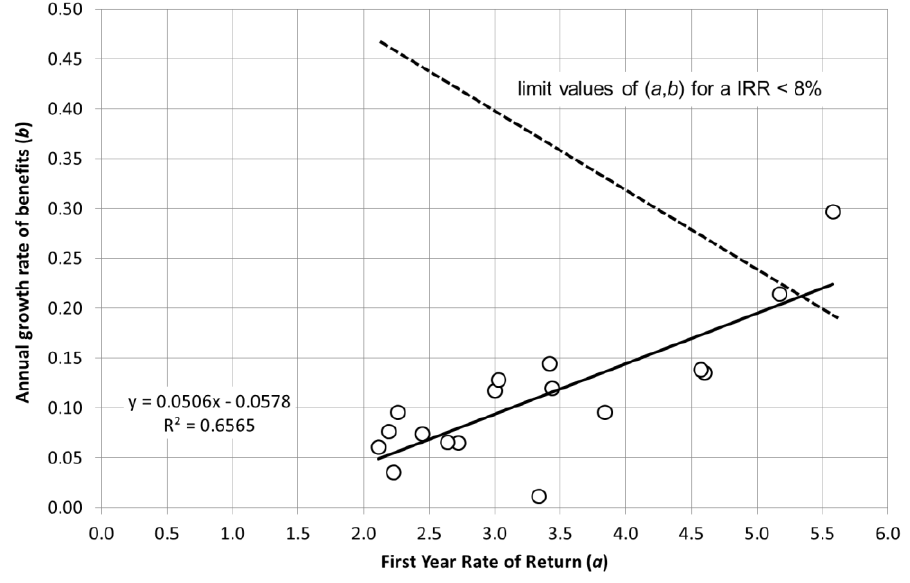
Figure 3. Relation between a and b – 17 French motorway projects (C* = 100 – d =